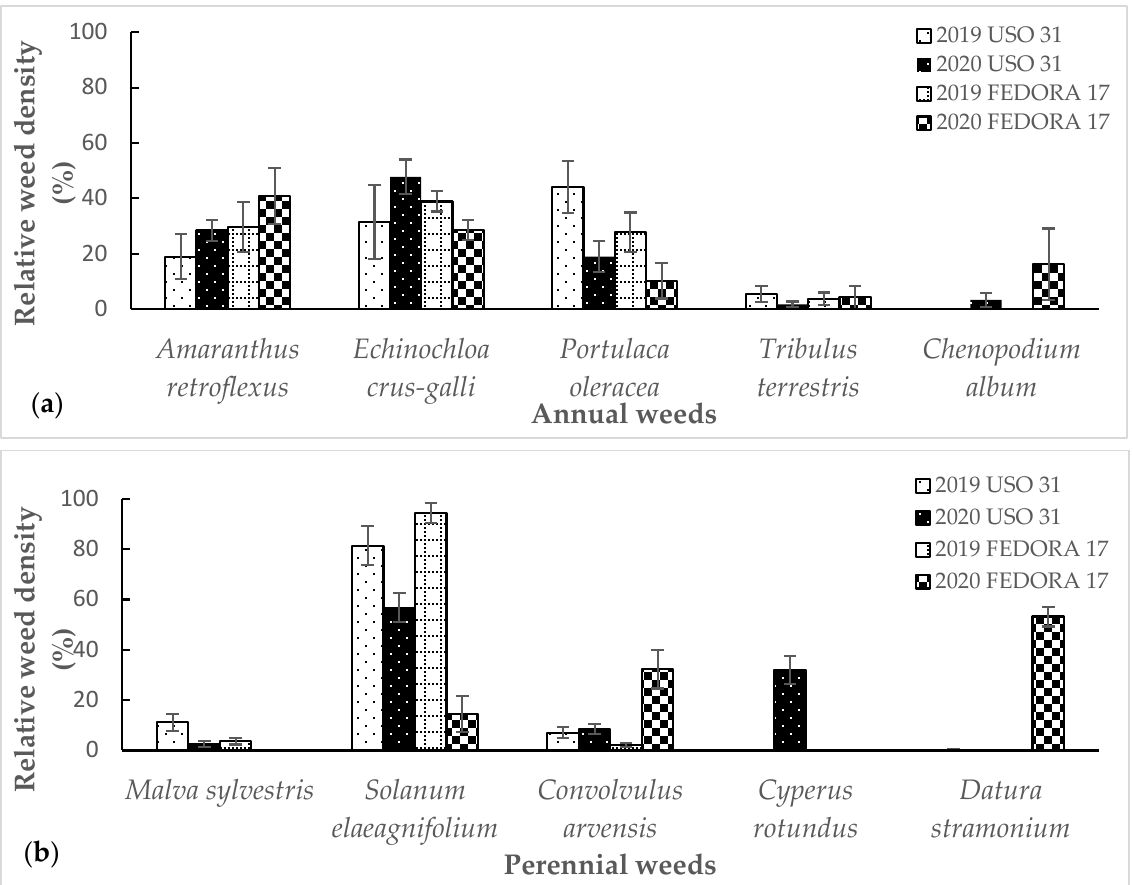
Figure 2. Relative weed density of annual ( a ) and perennial weed species ( b ) of hemp crop across the growing seasons 2019 and 2020. Vertical bars indicate the standard errors of the means.